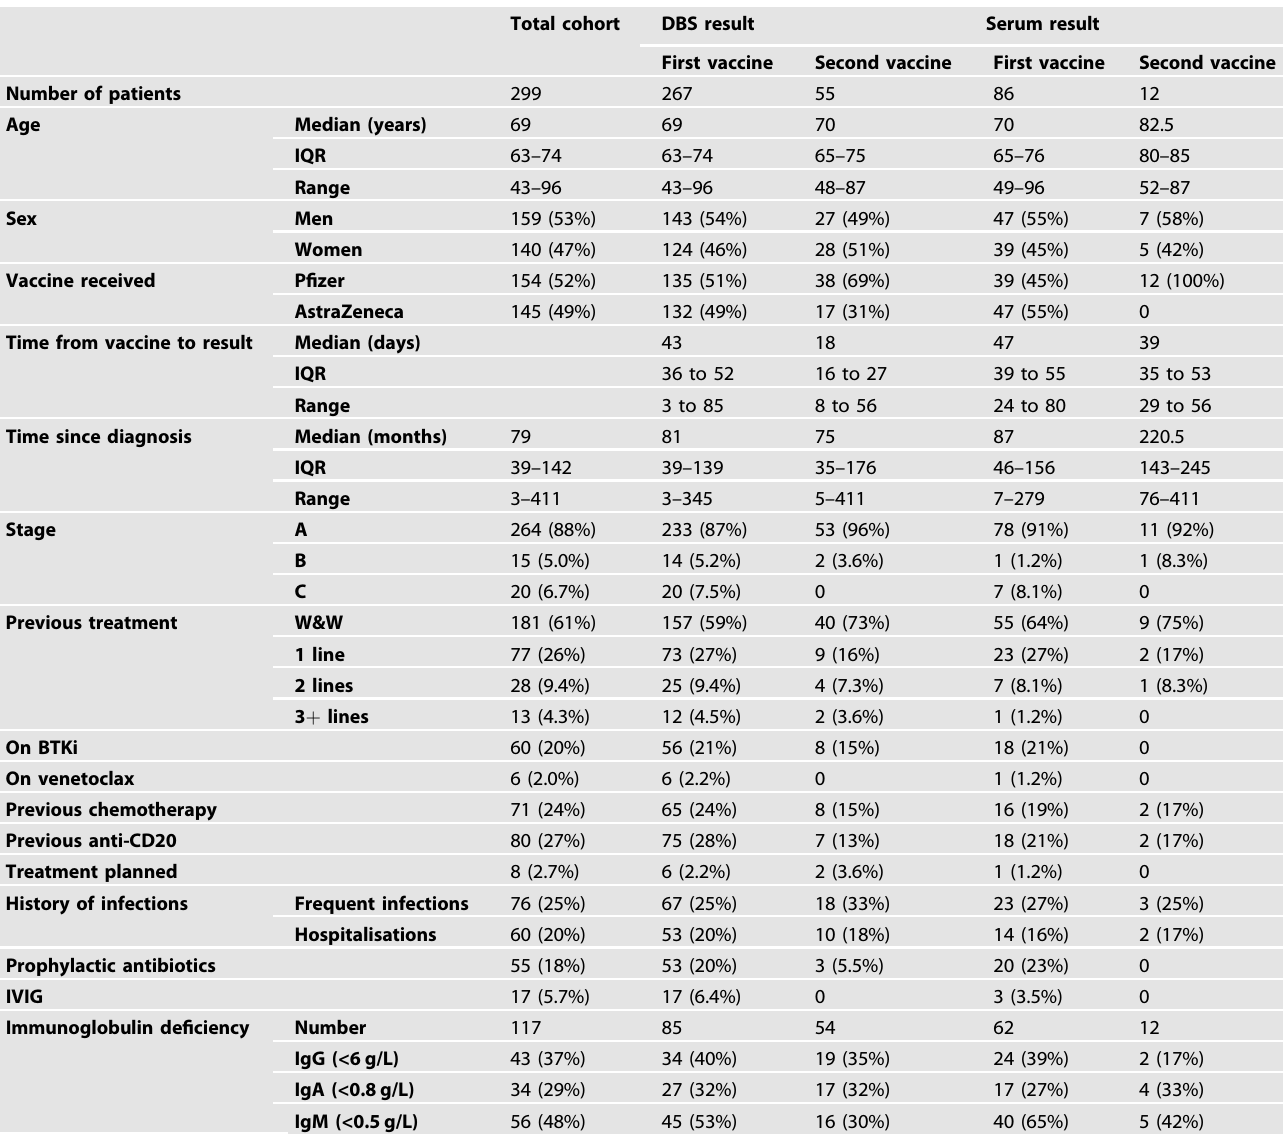
Table 1. Details of patient